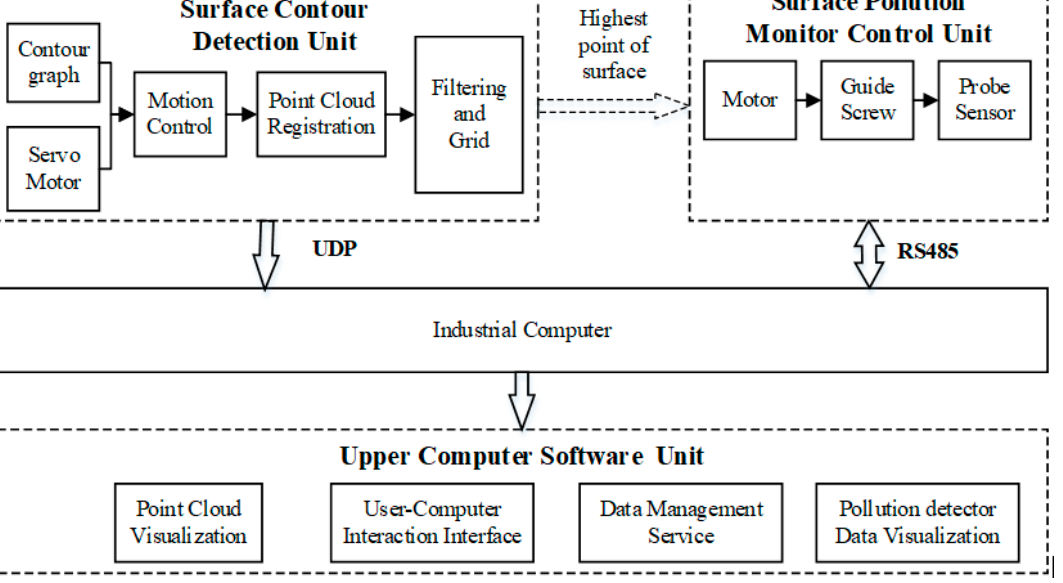
Figure 1. Block diagram of nuclear pollution detection scheme.